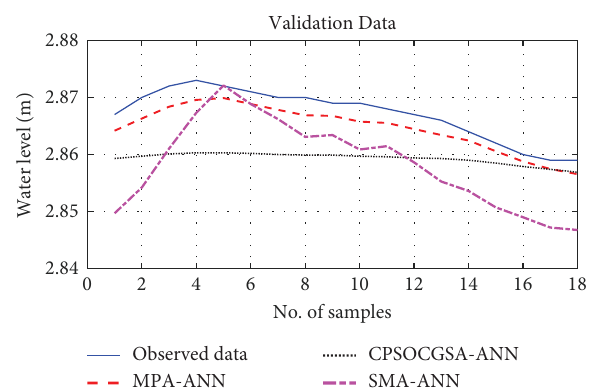
Figure 10: The comparison between actual and predicted data for MPA-ANN, CPSOCGSA-ANN, and SMA-ANN for the validation